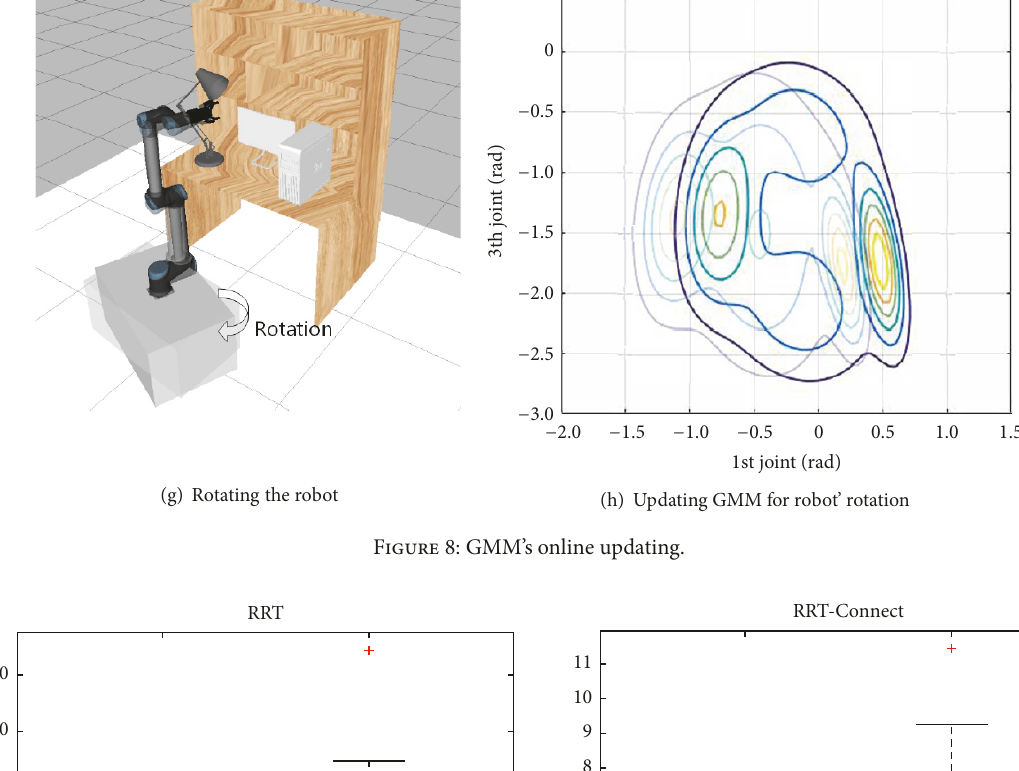
Figure 8: GMM’s online updating.